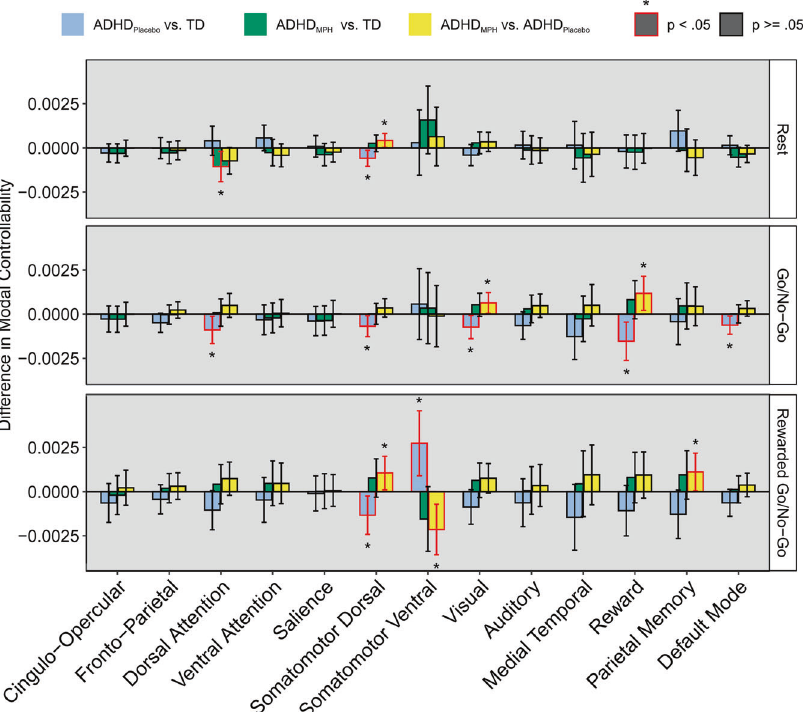
Fig. 3 Difference in modal controllability between ADHD on placebo and TD (blue bars), ADHD on MPH and TD (green bars), and within ADHD (yellow bars) for the three functional scan contexts (rest, go/no-go, rewarded go/no-go). Children with ADHD on placebo exhibited decreased modal controllability in the somatomotor dorsal network during rest, the dorsal attention, somatomotor dorsal, visual, reward, and default mode networks during the go/no-go task, and in the somatomotor dorsal network during the rewarded go/no-go task. Children with ADHD on placebo exhibited increased average controllability in the somatomotor ventral network during the rewarded go/no-go task. During rest, children with ADHD on MPH exhibited lower modal controllability in the dorsal attention network. For all cases in which children with ADHD on placebo exhibited signi fi cantly different modal controllability compared to TD children, those differences were no longer signi fi cant when comparing children with ADHD on MPH and TD children. This was supported by signi fi cant within-ADHD effects of MPH for the somatomotor dorsal network during rest, visual and reward networks during the go/no-go task, and the somatomotor dorsal and somatomotor ventral networks during the rewarded go no-go task. Bars correspond to the regression estimate of the relevant difference, controlling for age, biological sex, and in-scanner motion. Error bars correspond to 95% con fi dence intervals. Red outline and asterisk indicate statistical signi fi cance at p < signi fi cant within-participant effect of average controllability asso- ciated with MPH ( β ¼ (cid:2) 0 : 0012 ; p ¼ 0 : 04 and β ¼ 0 : 002 ; p ¼ 0 : 007 respectively). All other effects were non-signi fi cant (all p- values > 0.06; Fig. 2). For parameter estimates, see Tables S6, S7, and S8 in